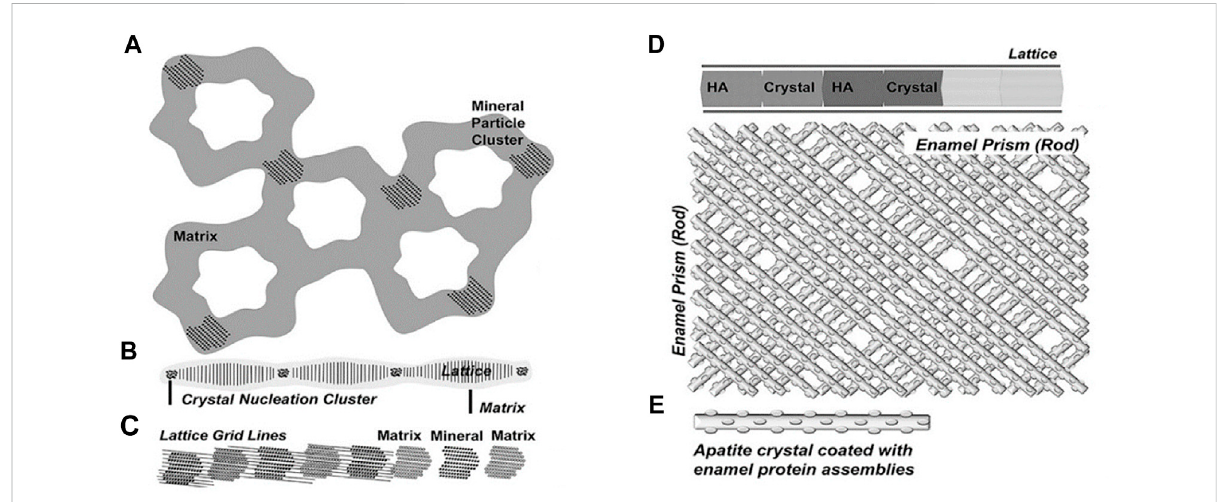
FIGURE 4 Five successive stages of enamel crystal precipitation and extension. (A) Stage of calcium phosphate particles precipitating and adhering to the organized enamel protein matrix, (B) Formation of initial crystal needle through single nucleation sites, (C) Extension of enamel crystals by lattice- guided alignment of individual apatite crystals, (D) Stage of crystal further extension and growing, (E) Enamel prisms (rods) are formed by the cross arrangement of single enamel crystals. Reprinted with permission from [ (Jokisaari et al., 2019) ]. Copyright © 2019 American Chemical